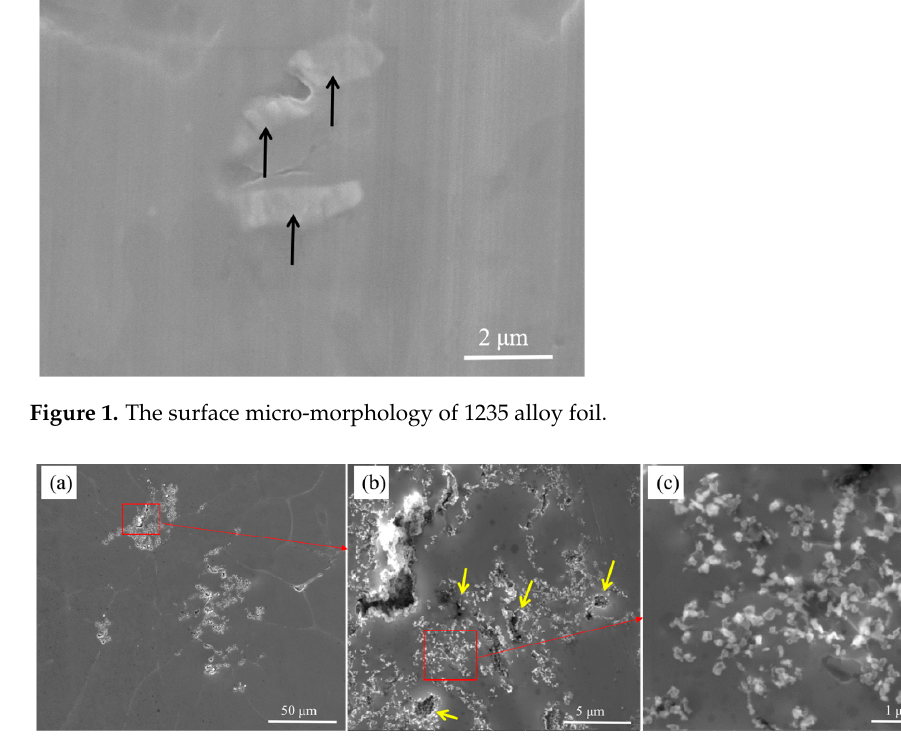
Figure 2. ( a ) The micro-morphology of 1235 alloy foil after being held in the commercial pure alu- minum melt for 15 min; ( b ) High magnification view of the area denoted by red frame in ( a ); ( c ) High magnification view of the area denoted by red frame in ( b ).